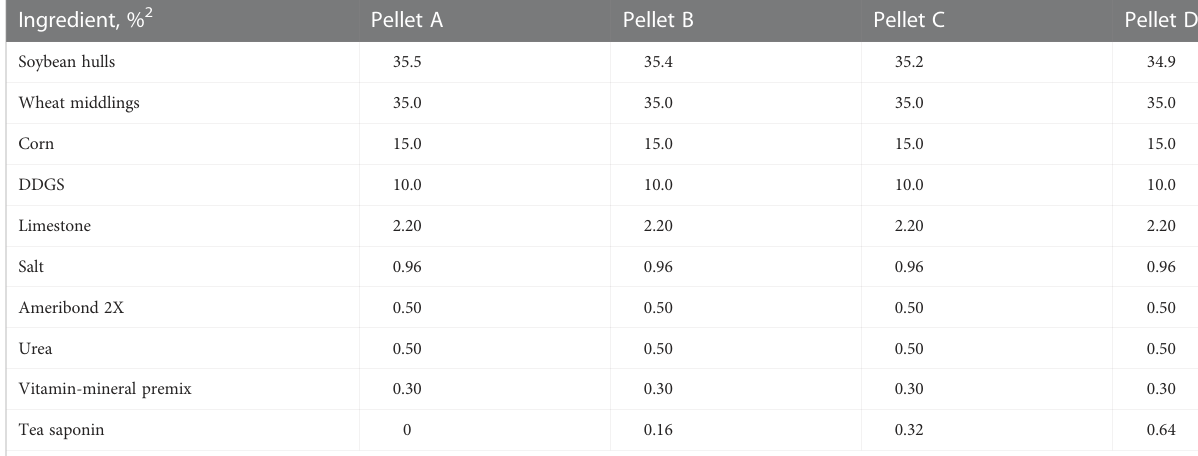
TABLE 1 Ingredient composition of treatment pellets 1 .